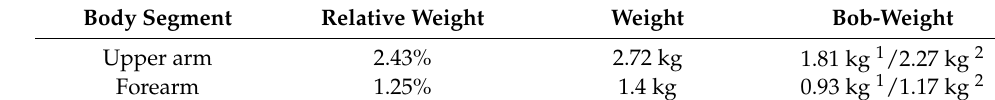
Table 2. The bob-weight scheme of a single arm.